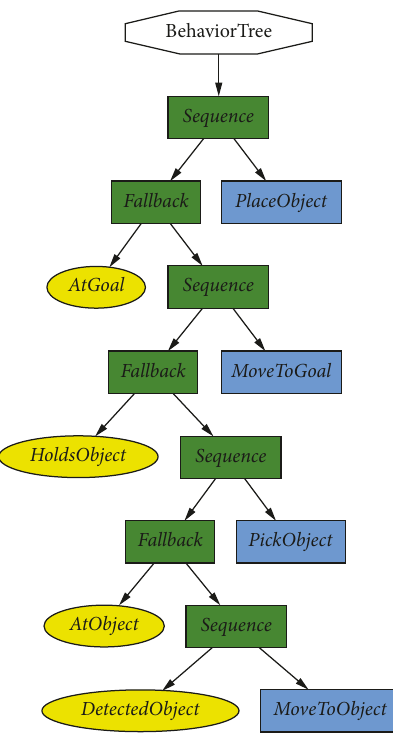
Figure 10: Another result for step 3—by backward chaining.